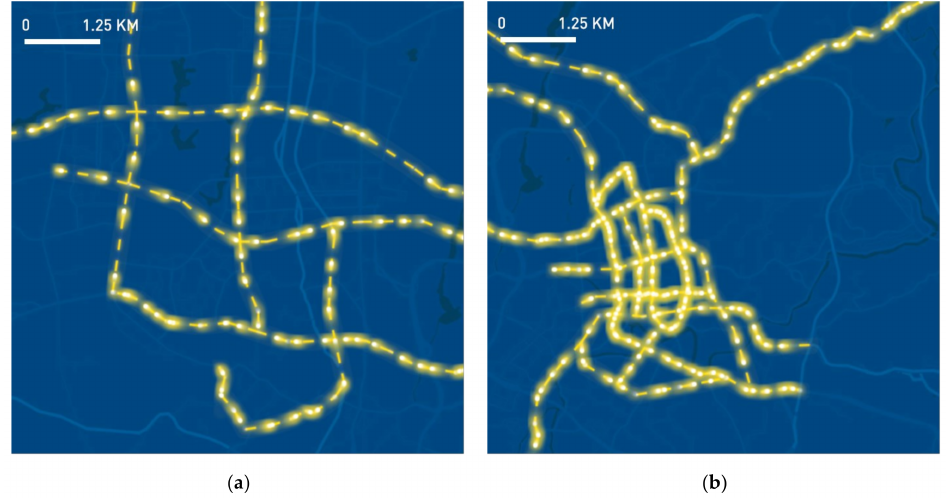
Figure 10. Visualization map of urban hot routes in areas with high vehicle density. ( a ) Hot routes in the west part of Guiyang. ( b ) Hot routes in the east part of